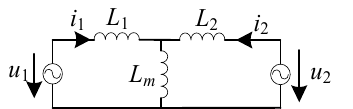
Figure 4. The equivalent circuit model of a two-port converter.